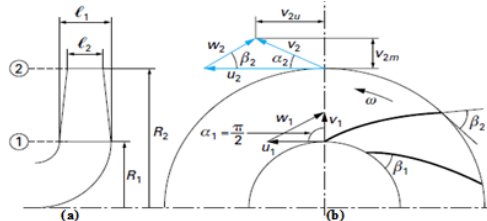
Figure 1: Velocity triangles (input-output) in a centrifugal compres- sor